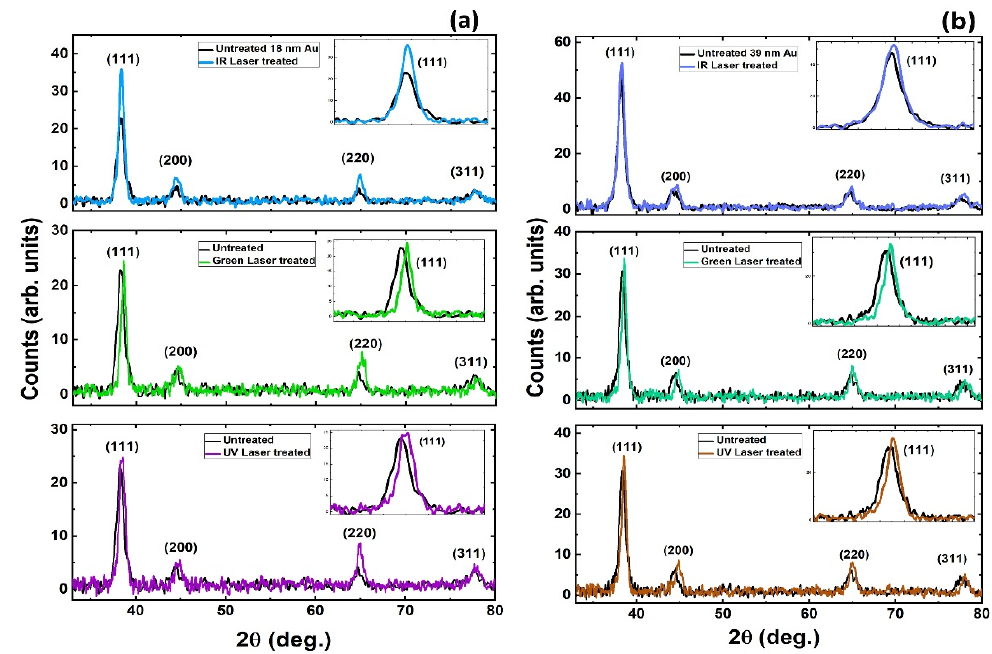
Figure 6. XRD spectra of thin films before and after laser scanning for ( a ) 18-nm and ( b ) 39-nm thick Au films on quartz substrate.